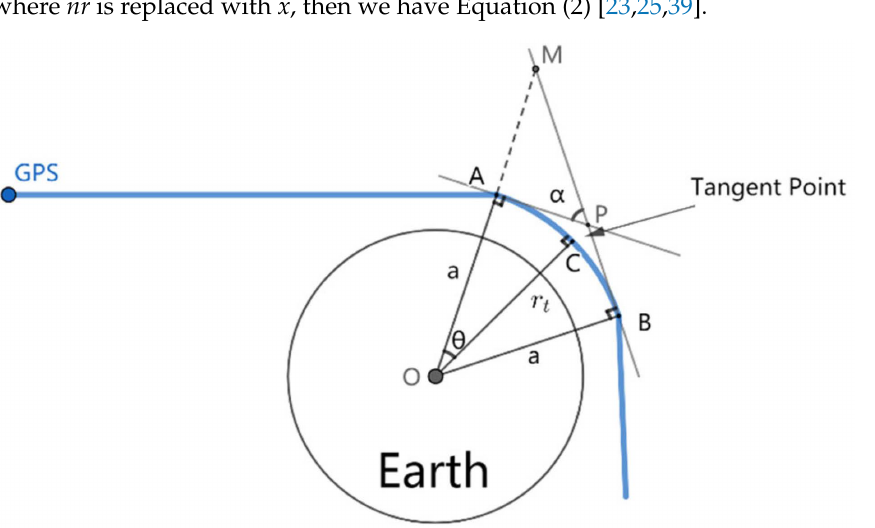
Figure A1. Schematic of radio occultation geometry based on the spherically symmetric atmosphere assumption. That is, if triangles of ∆ AOC and ∆ BOC are symmetric (equal), then α = 2 θ . OA(a), OB(a), and OC(rt) on the ray path are the position vectors of a transmitter, receiver, and tangent point, respectively. The ray is over bent for the clarity of the geometry